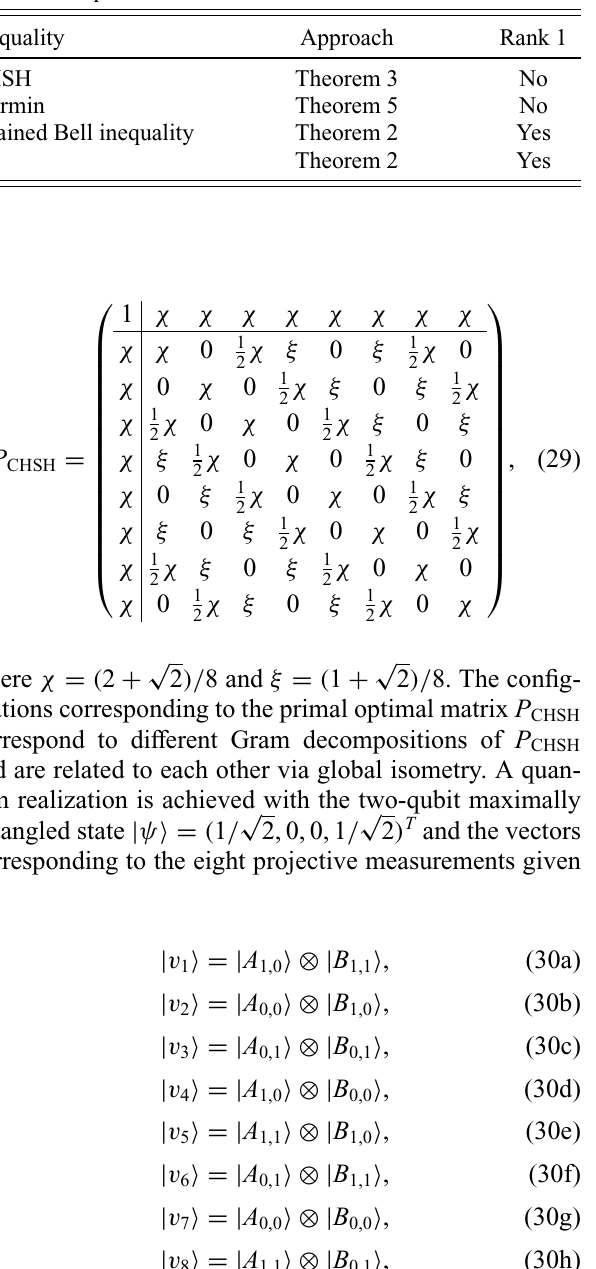
TABLE I. Summary of test cases. This table summarizes what theorem guarantees the self-testing for each Bell inequality. Some of our results assume the rank-1 condition, i.e., the pro- jection operator is assumed to be rank 1. The column “Rank 1” shows the requirement for this